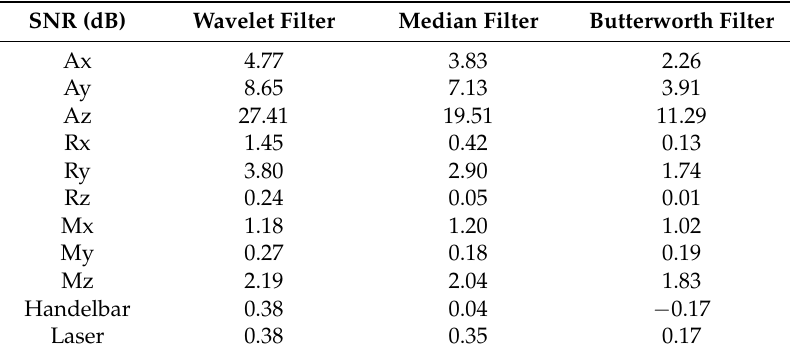
Table 1. Comparison of the signal-to-noise ratio (SNR) of the three filters.